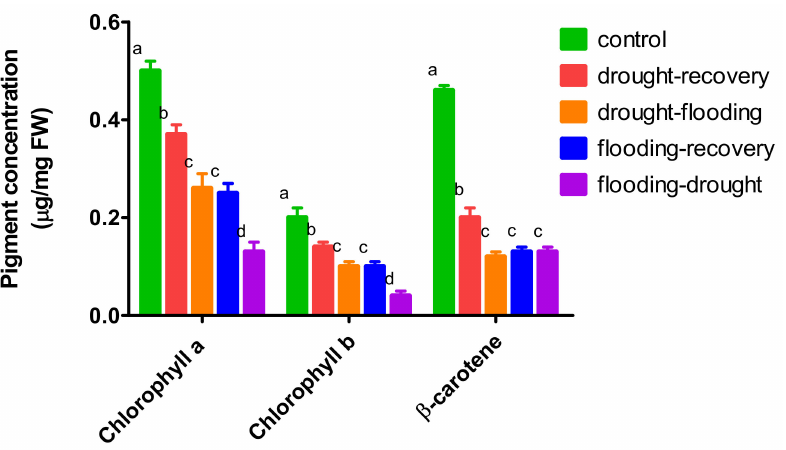
Figure 4. Pigment concentration from O. basilicum leaves under different stress conditions.